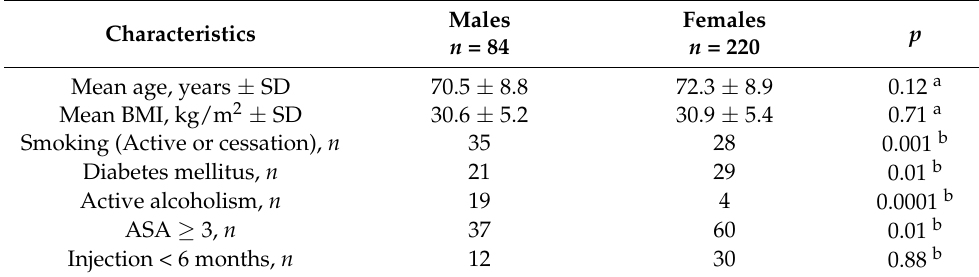
Table 4. Comparison between males and females.